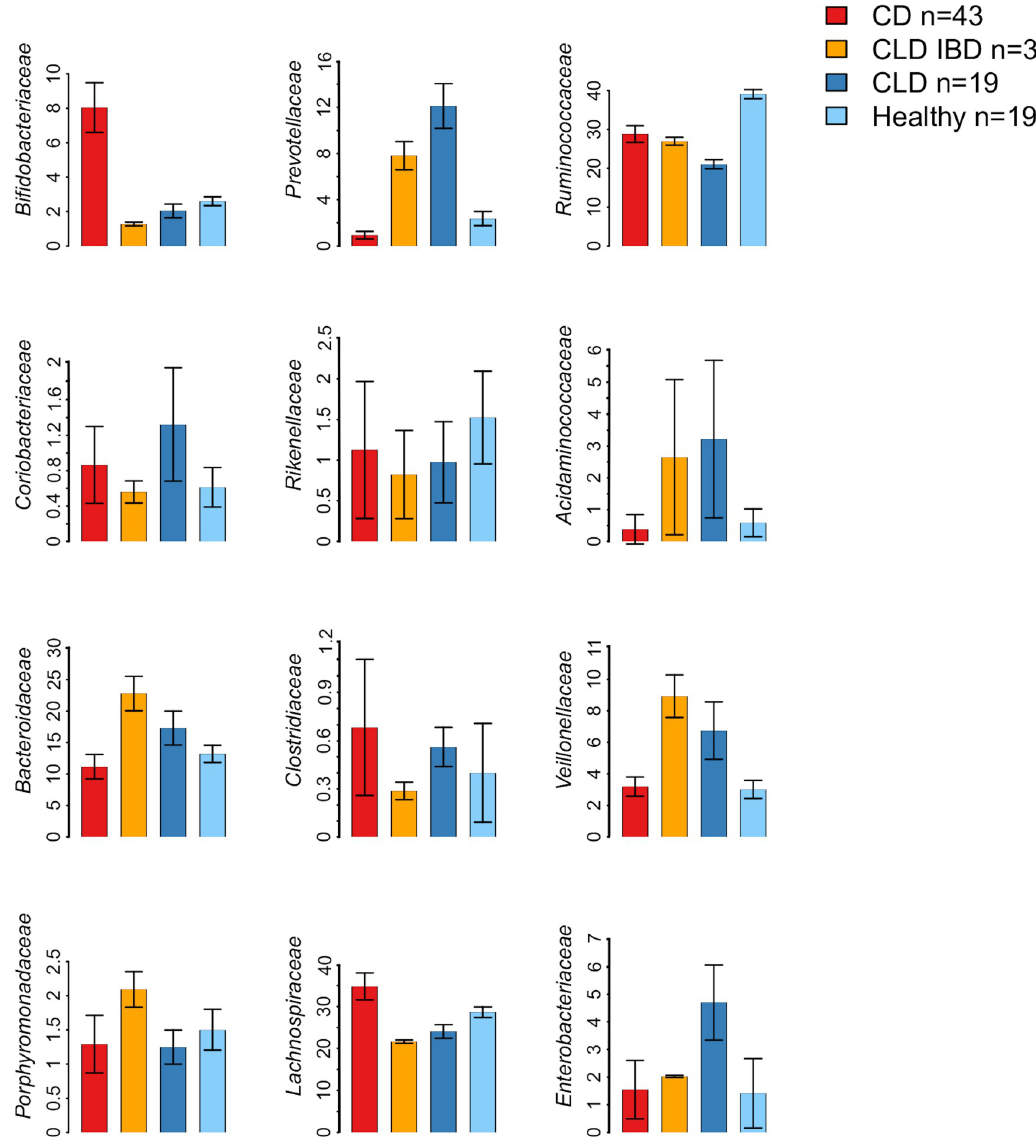
Fig 3. Microbiota composition in congenital chloride diarrhea (CLD), CLD-associated IBD (CLD IBD), Crohn’s disease (CD), and healthy controls. Shown are family-level microbiota composition for the taxa with significant differences ( P < 0.01) between CLD and healthy subjects. Data are presented as group means and standard errors of the mean. Detailed data are presented in S3 Table